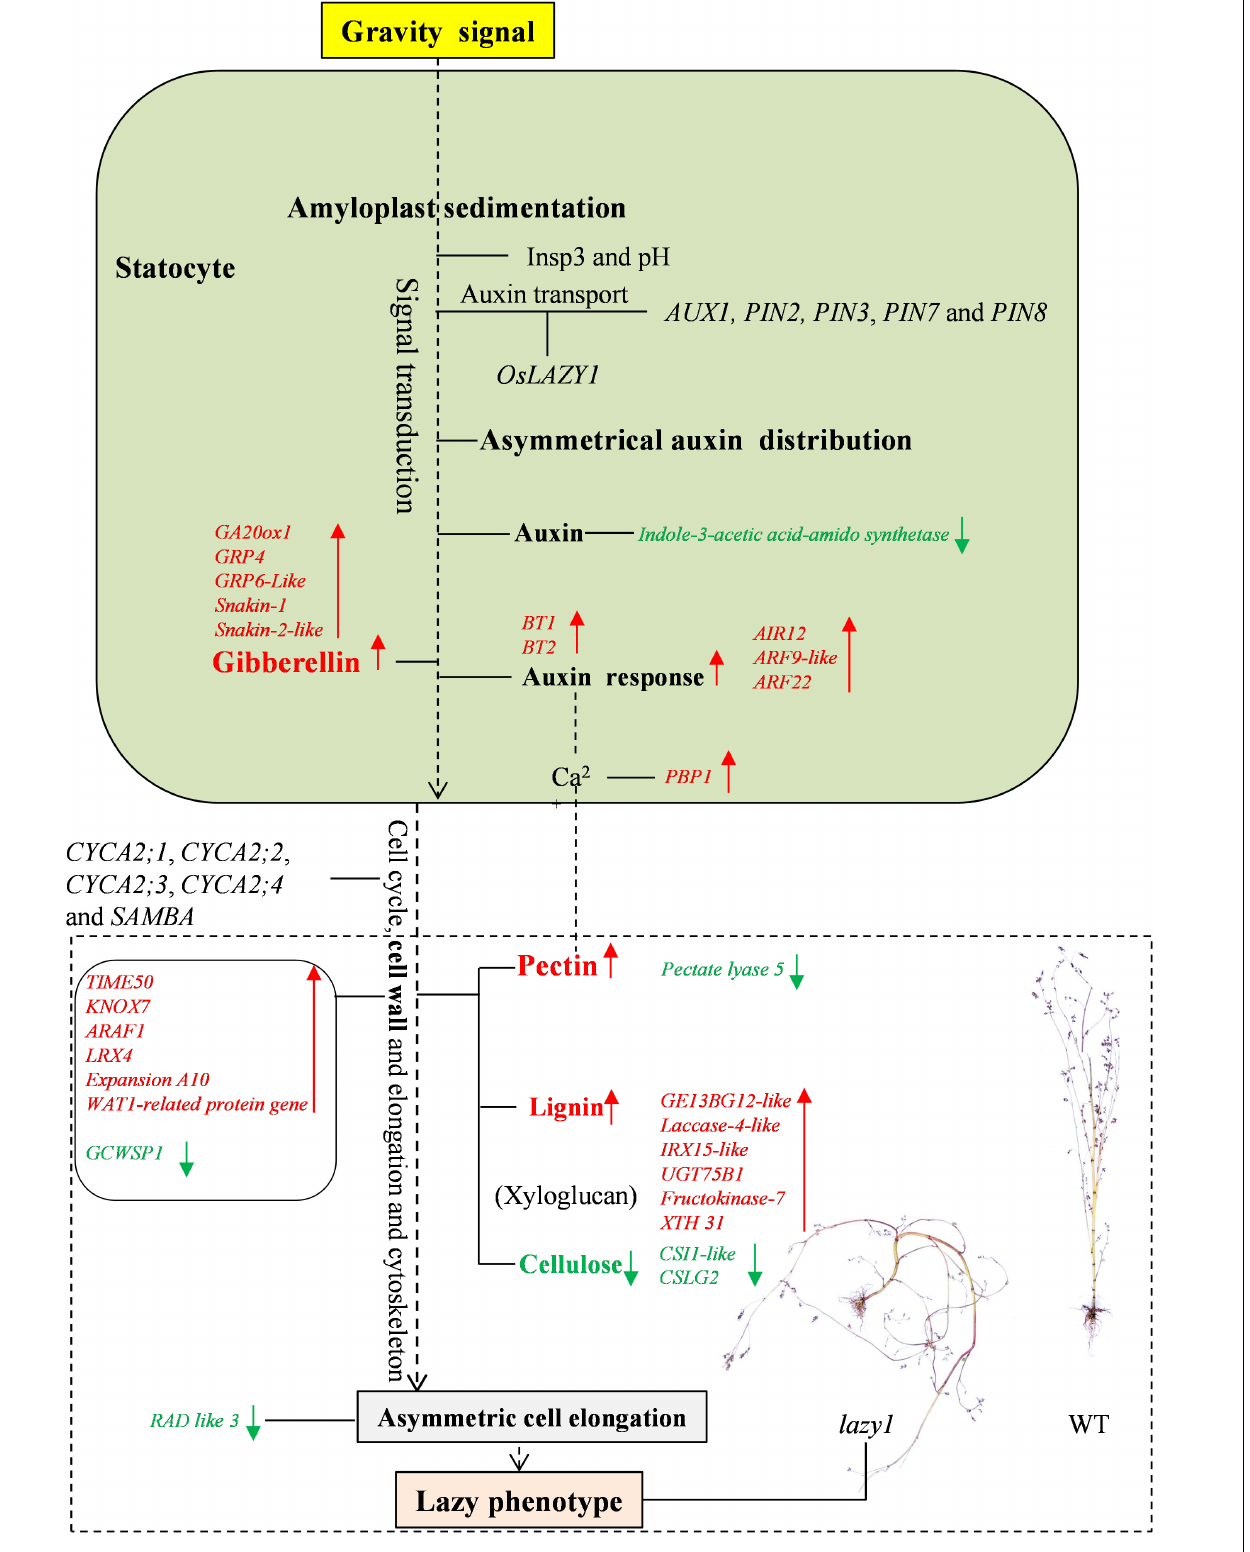
Frontiers in Plant Science |